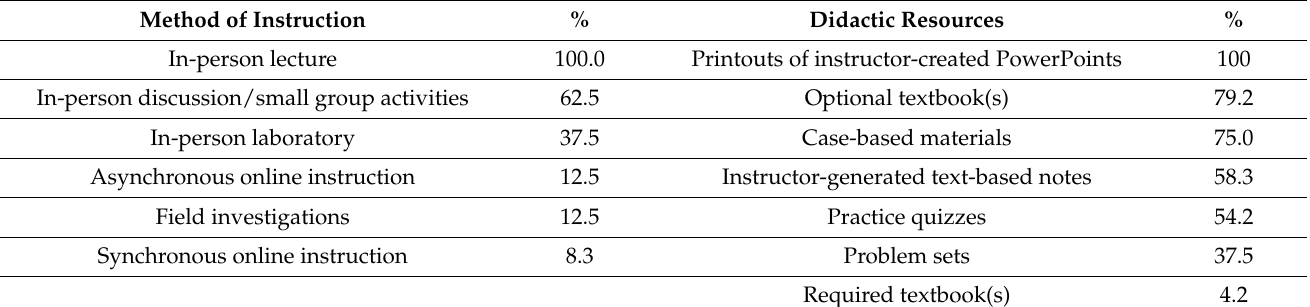
Table 1. Current didactic resources and primary method of instruction provided in toxicology courses between 2018 and 2019 at AAVMC member institutions ( n = 24). Percentage of